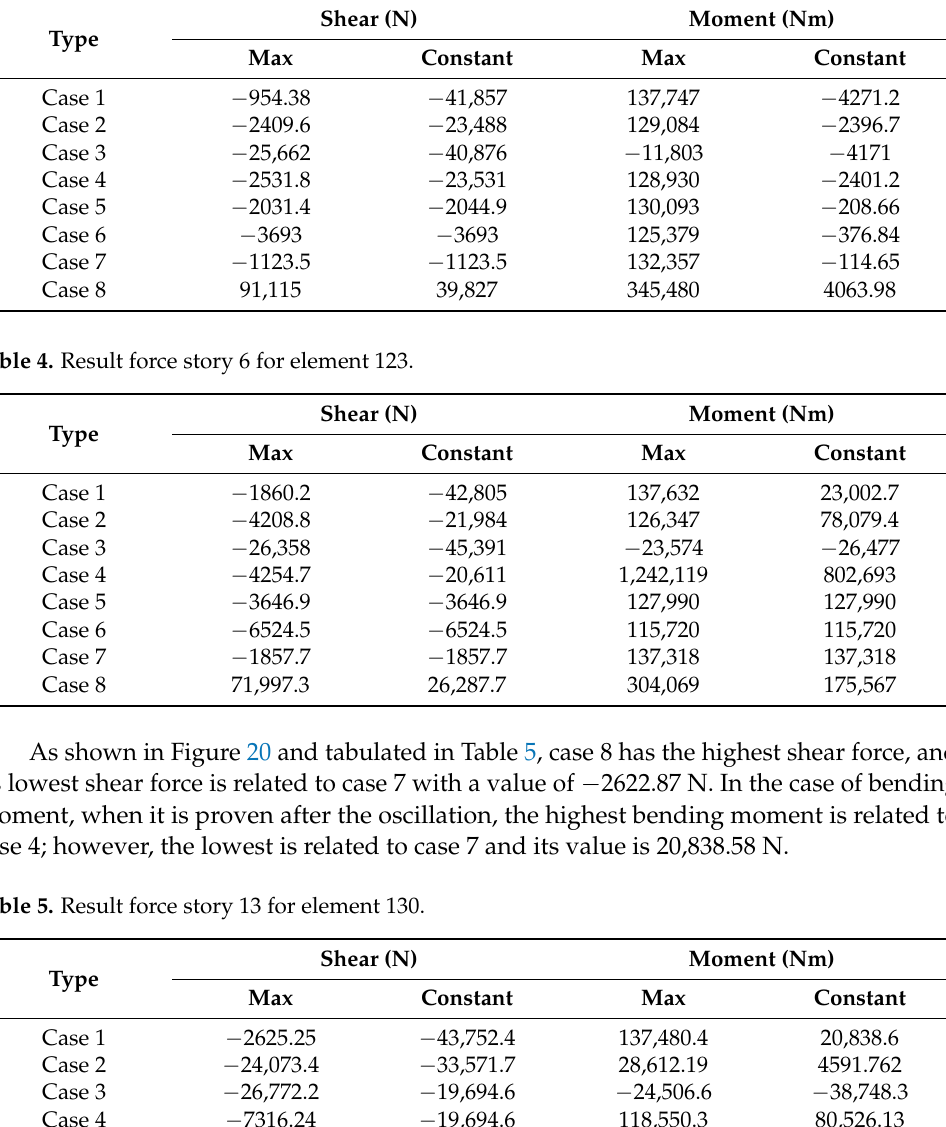
Table 3. Result force story 1 for element 118.